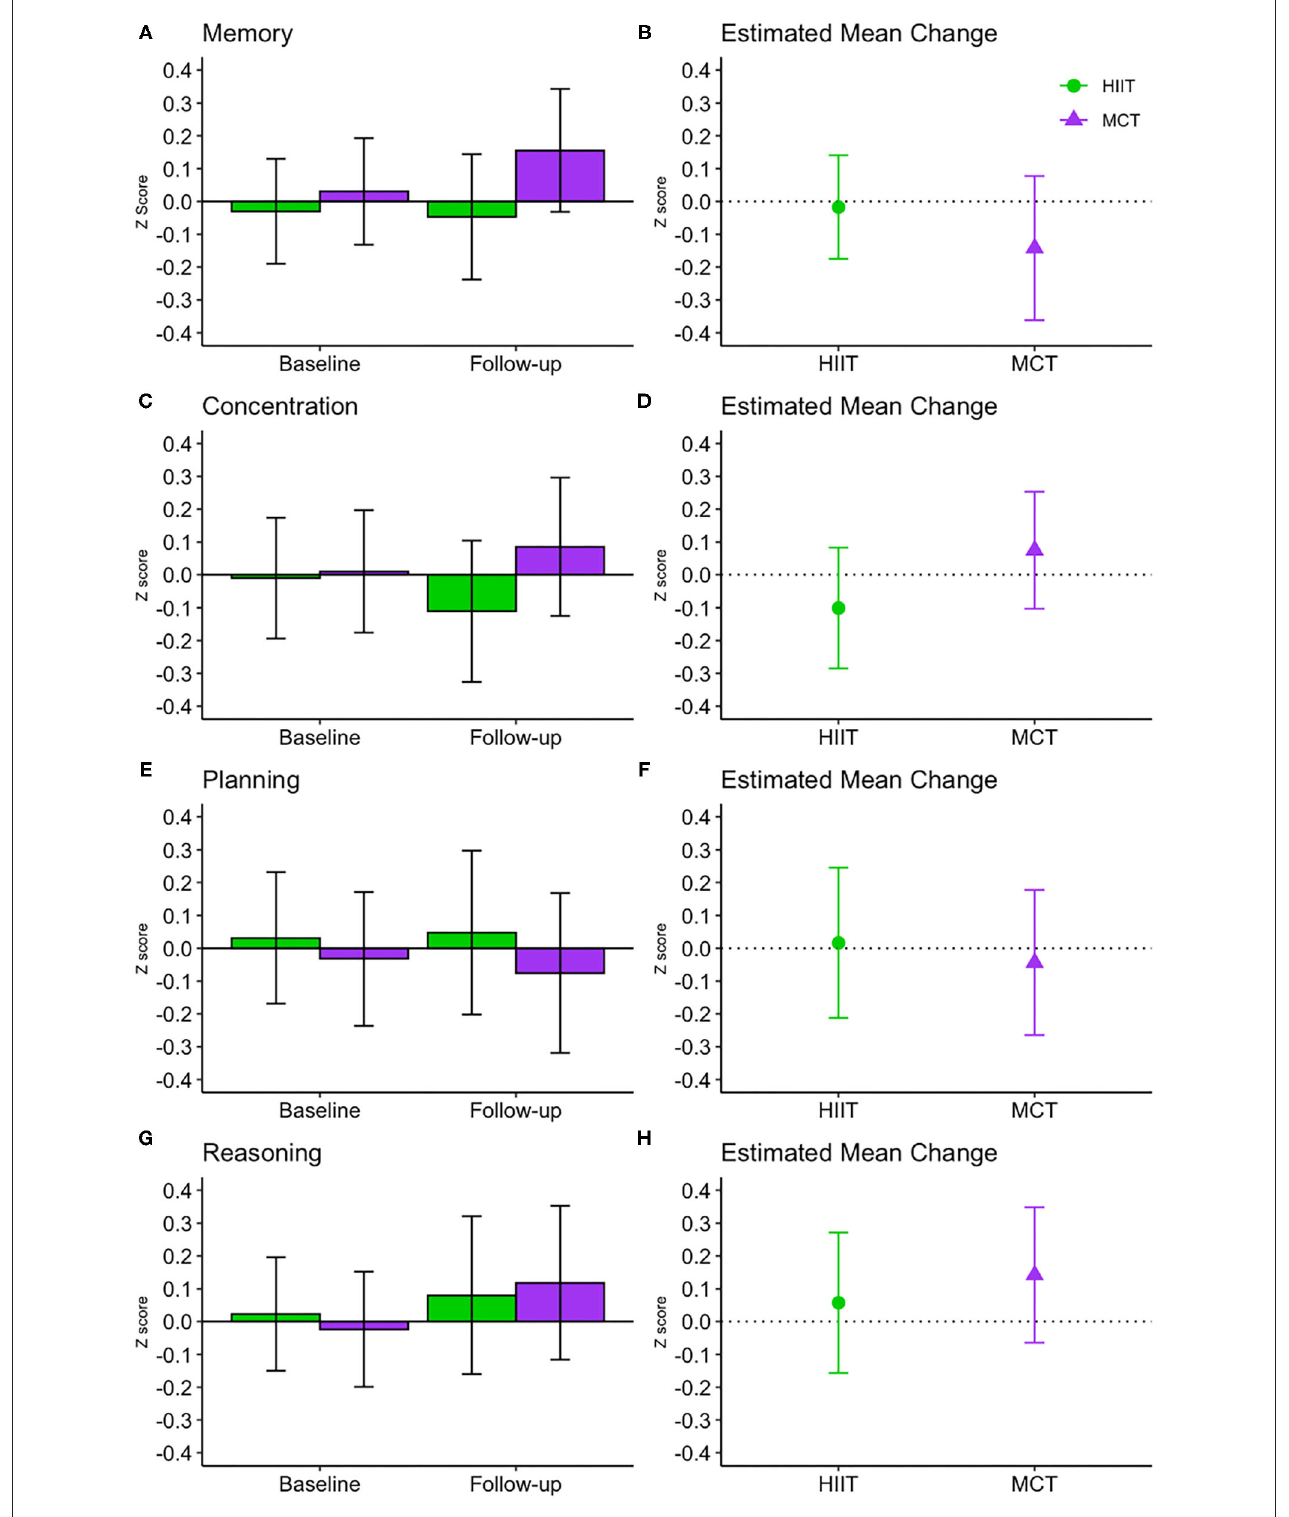
FIGURE 5 | Baseline and follow-up means for domain-specific cognitive function ( A,C,E,G , show group mean and 95% CI) and estimated mean change from baseline to 6 months ( B,D,F,H show estimated mean change and 95% CI). CI, confidence interval; HIIT, high-intensity interval training; MCT, moderate-intensity continuous